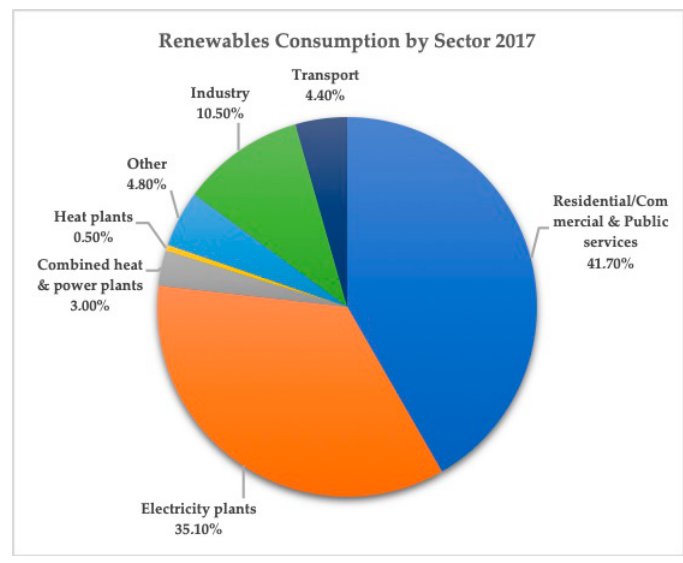
Figure 3. Renewables’ Consumption by Sector 2017 (Source: IEA).